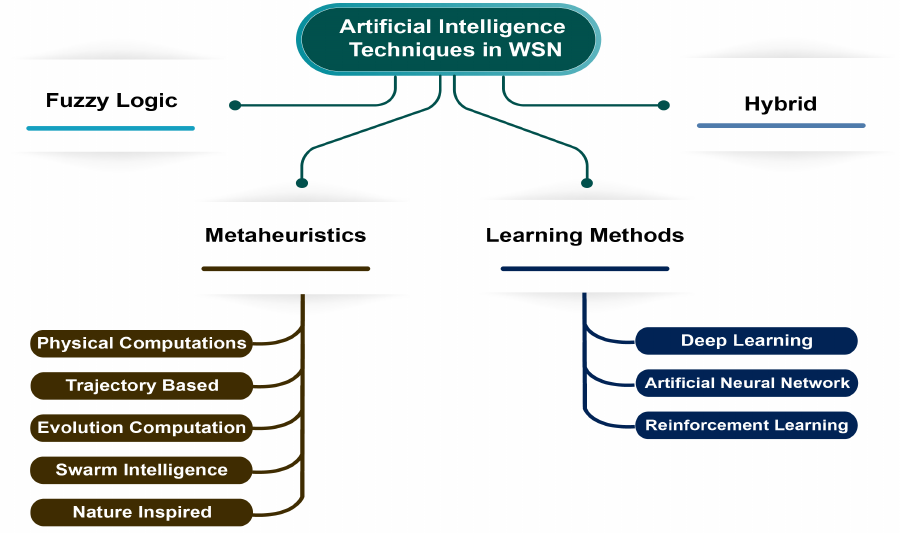
Figure 3. AI methods applied to address Data Collection, Aggregation and Dissemination WSN